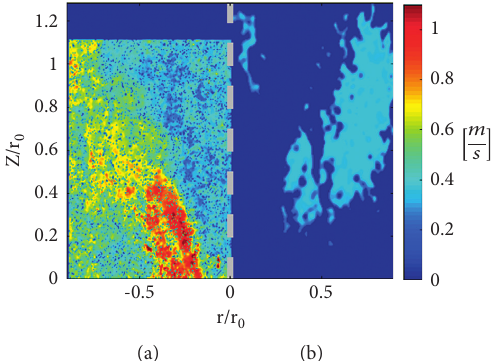
Figure 6: Comparison of the kolmogorov velocity (a) and laminar flame speed (b). Representative data are shown for the first phase of the